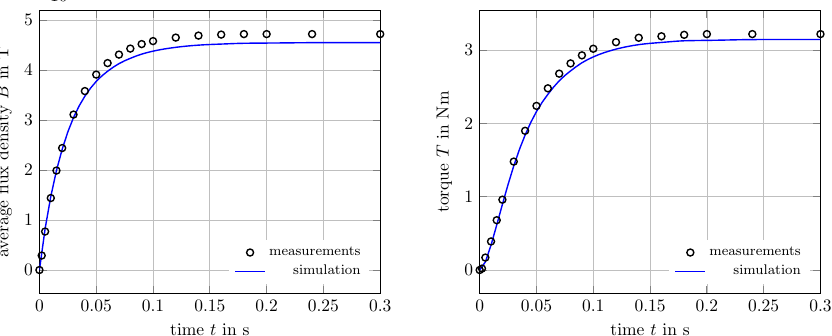
Figure 8. TEAM 24 validation for the average flux ( left ) and torque on the rotor domain ( right